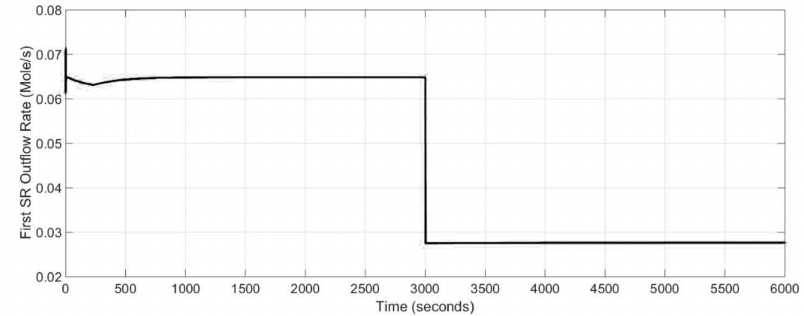
Figure 12. Dynamic response of the steam reformer molar flow rate for different stack drawn current